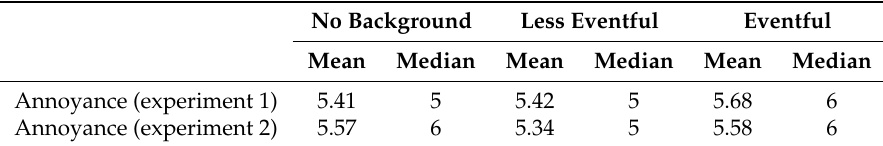
Table 5. Mean and median annoyance for different background sound types. No Background Less Eventful